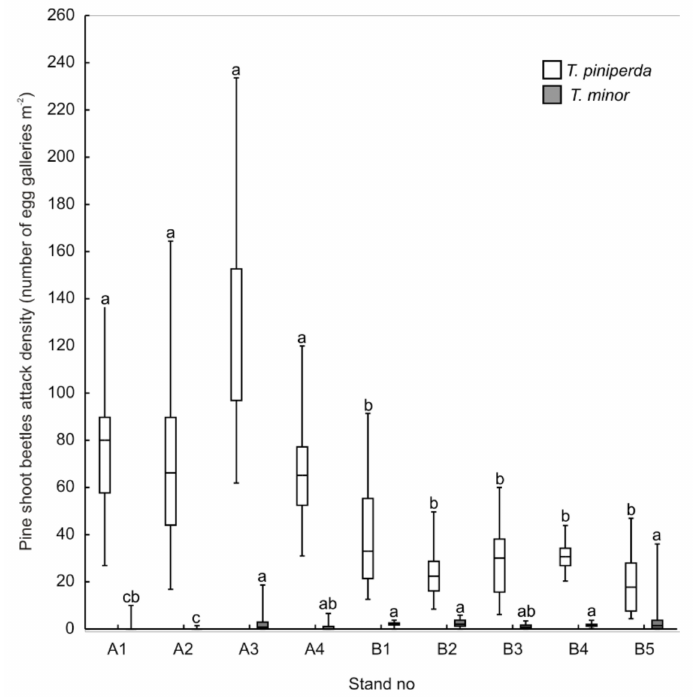
Figure 4. Mean infestation density by pine shoot beetles of trap logs. a , b, c the value of density infestation marked with different letters indicate statistically significant differences in the stands (Kruskal-Wallis test, p <